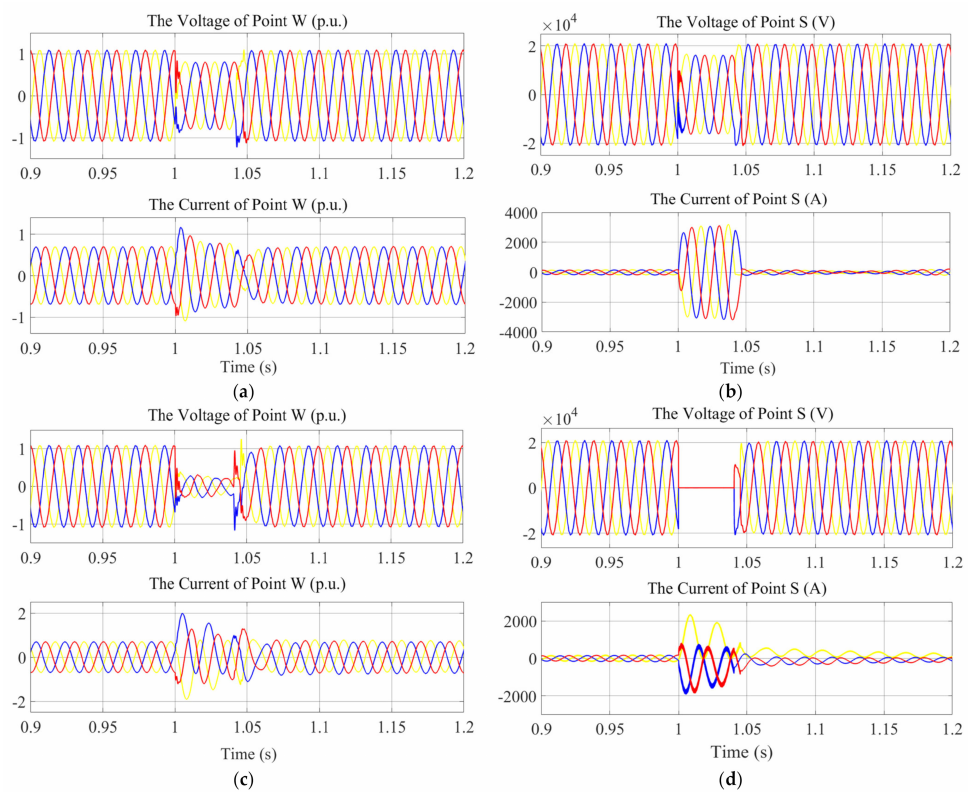
Figure 8. Dynamic characteristics of voltage and current with three − phase short circuit fault of point H occurring as 1.0 s and cleared at 1.04 s. ( a ) Dynamic characteristics of voltage and current of point W with three − phase short circuit fault of point H occurring at 1.0 s and cleared at 1.04 s. ( b ) Dynamic characteristics of voltage and current of point S with three − phase short circuit fault of point H occurring at 1.0 s and cleared at 1.04 s. ( c ) Dynamic characteristics of voltage and current of point W with three − phase short circuit fault of point S occurring at 1.0 s and cleared at 1.04 s. ( d ) Dynamic characteristics of voltage and current of point S with three − phase short circuit fault of point S occurring at 1.0 s and cleared at 1.04